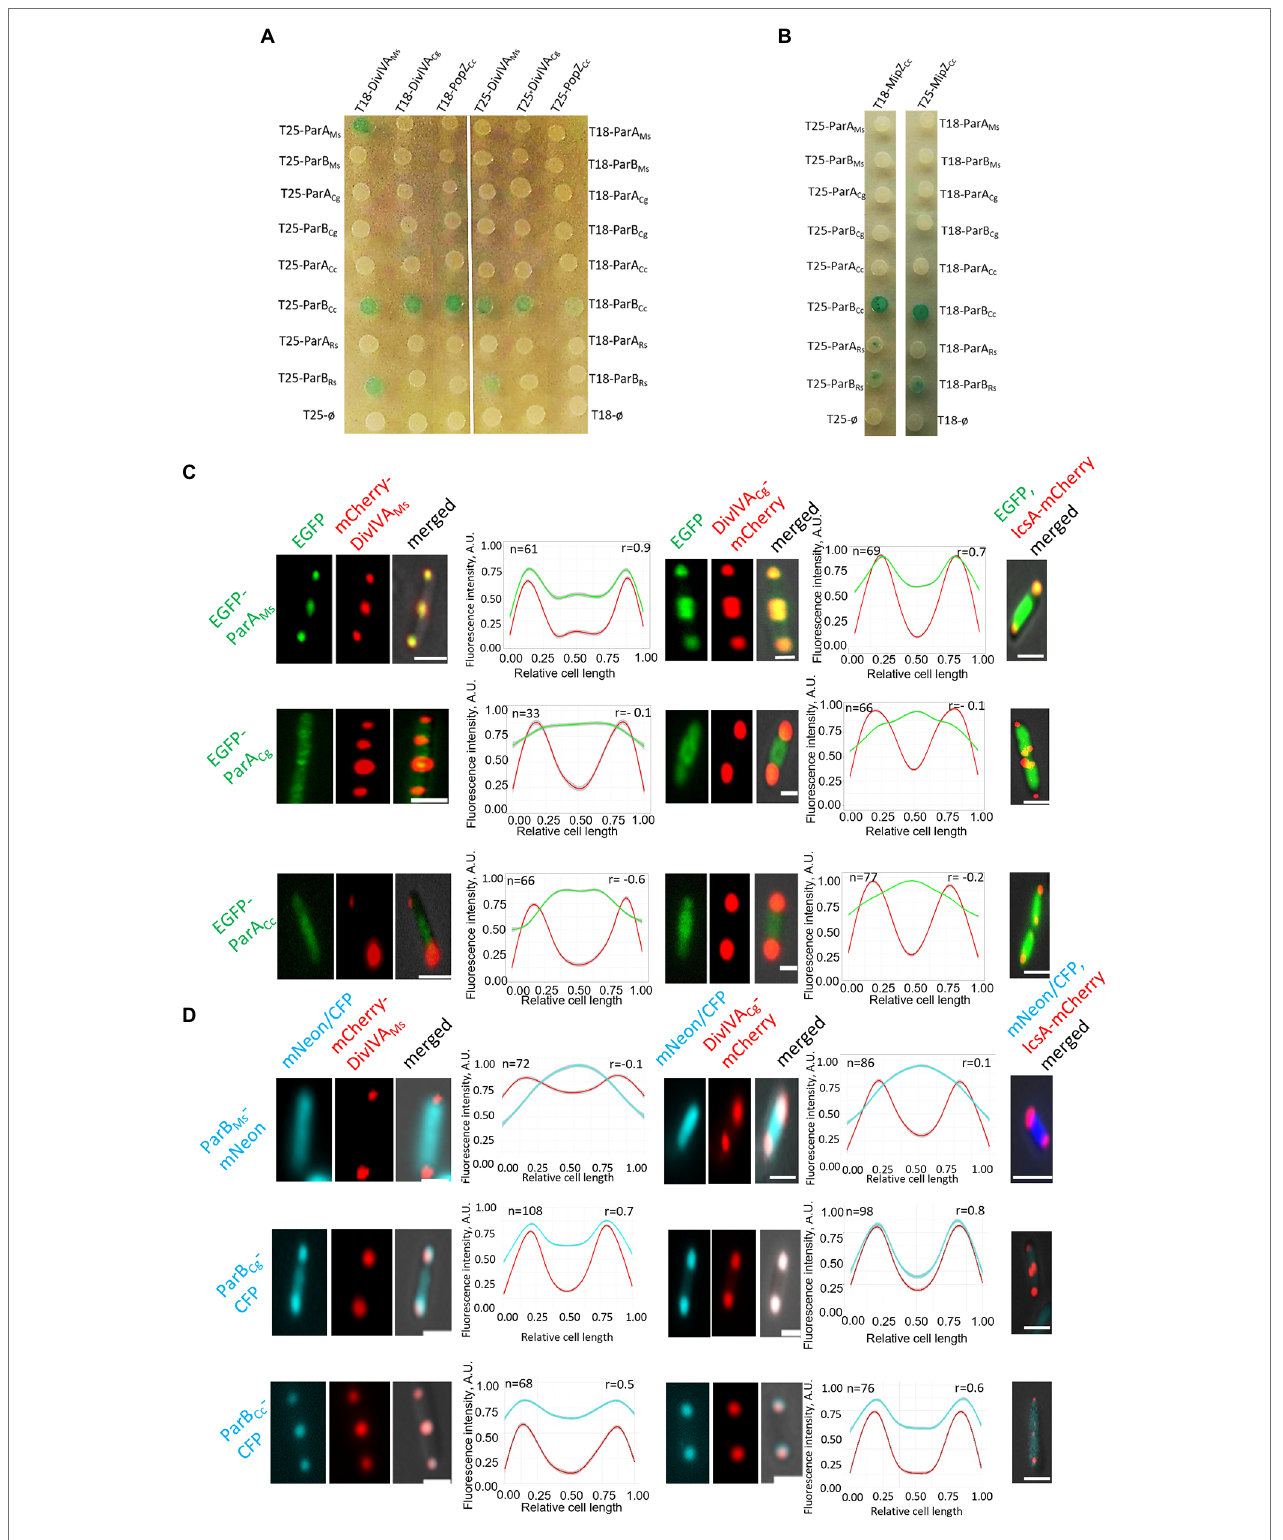
FIGURE 3 | Genus-specific interactions between ParA or ParB proteins and polar partner proteins DivIVA and PopZ. (A) BTH assays testing interactions between M. smegmatis and C. glutamicum DivIVA (DivIVA Ms and DivIVA Cg ) or C. crescentus PopZ and ParA or ParB proteins from M.